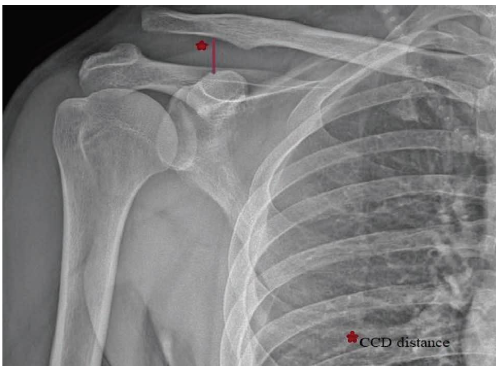
Figure 1: Measurement of the coracoclavicular distance (CCD) of a patient with Rockwood type III acromioclavicular joint dislo- cation on the preoperative anterior-posterior view. Te CCD is the vertical distance between the coracoid’s uppermost border and the inferior border of the